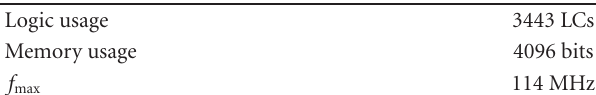
Table 1: Synthesis results for the tracing unit on the Ultera Stratix II S180